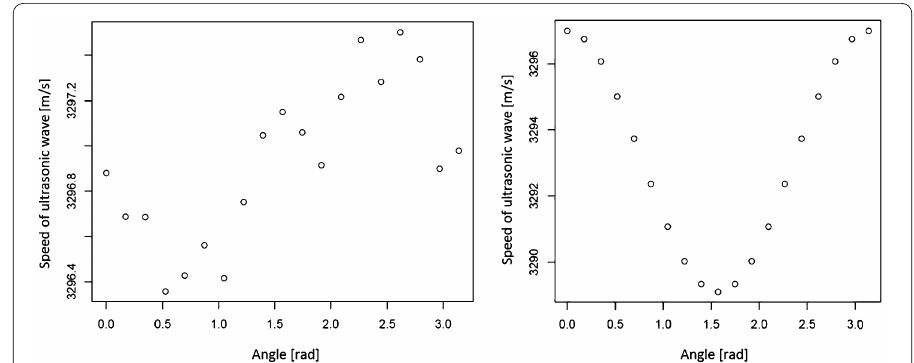
Figure 2 Left: Speed variation influenced by stress. Right: Speed variation due to texture